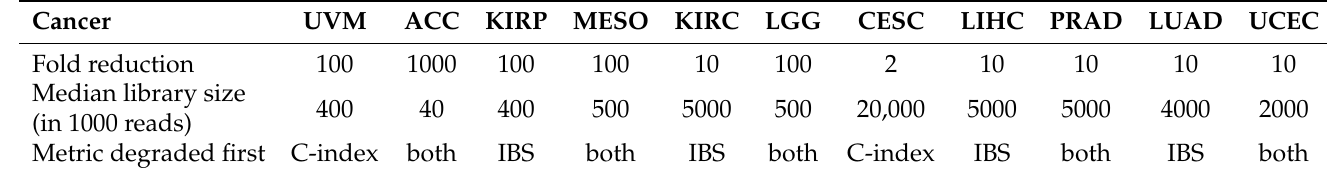
about 500,000 aligned reads. For KIRC and LGG the sequencing depth can be even